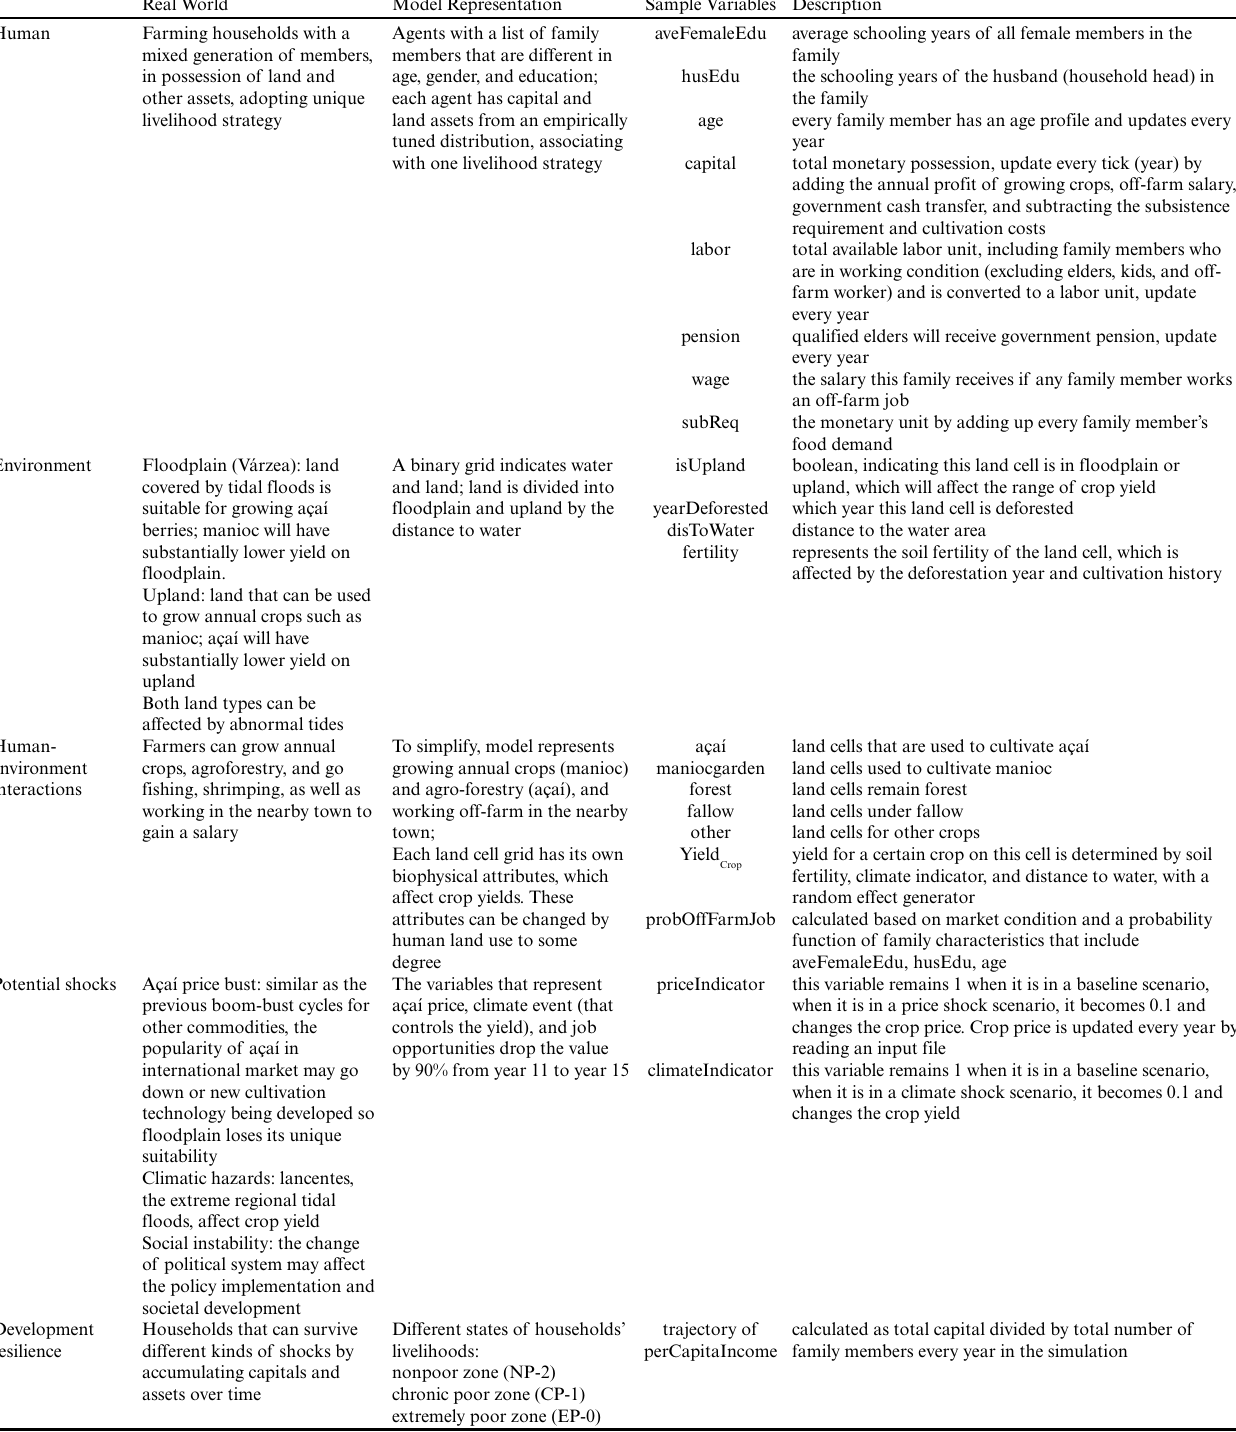
Table 1 . Representing the smallholder system using an agent-based